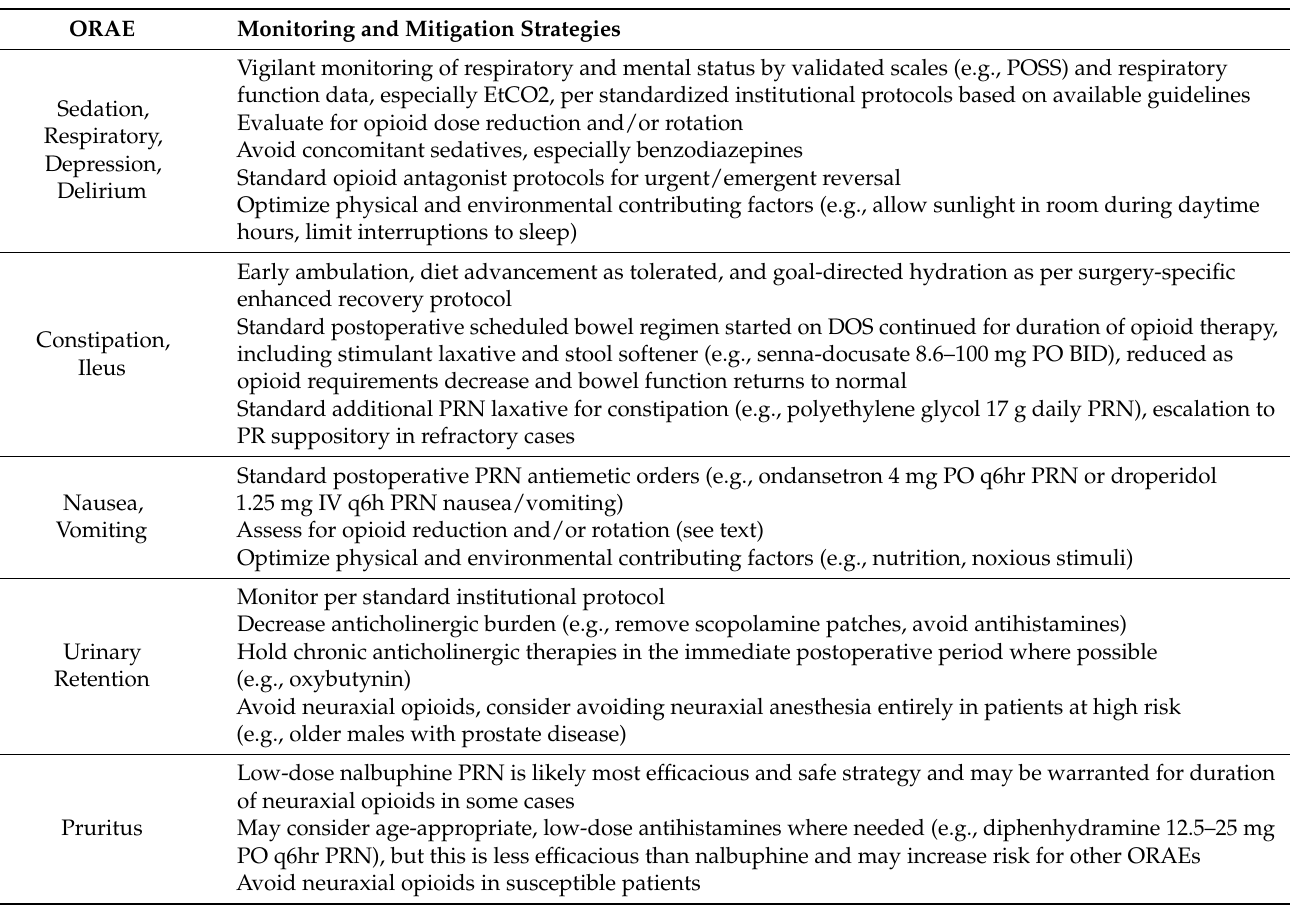
Table 10. Recommended Monitoring and Mitigation Strategies for Postoperative